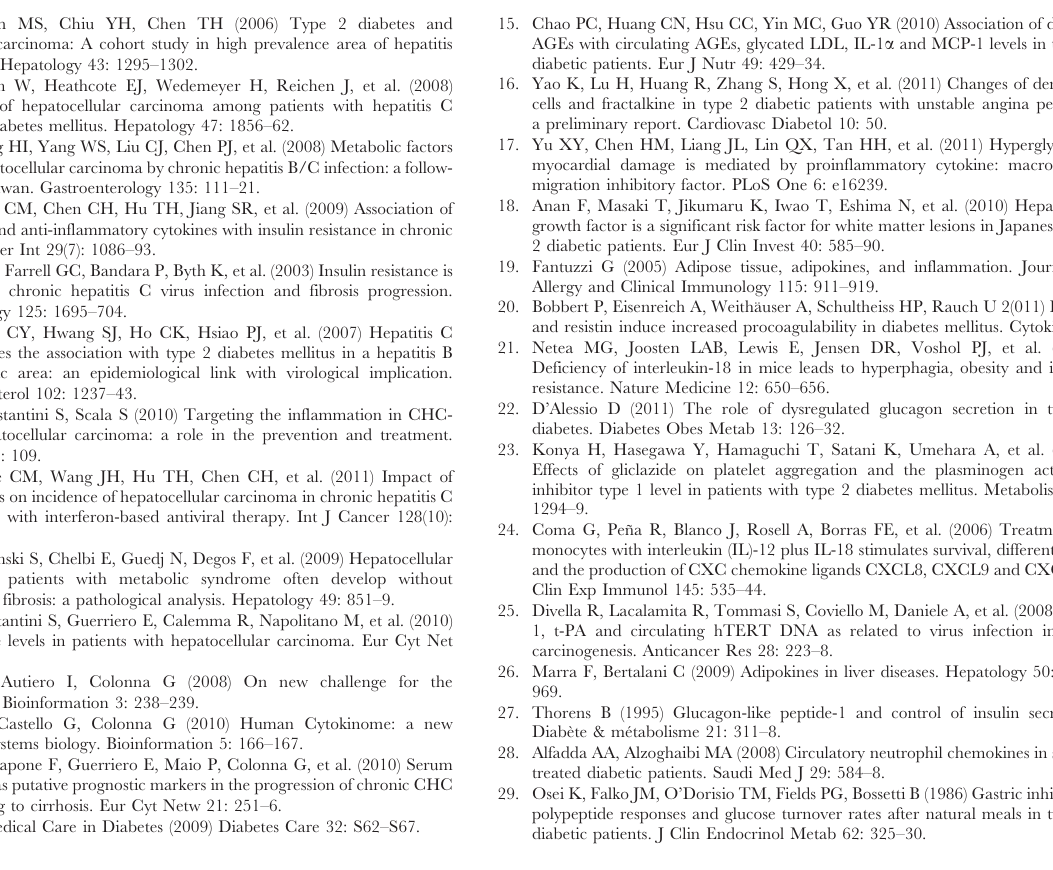
Table S1 List of molecules involved in the network